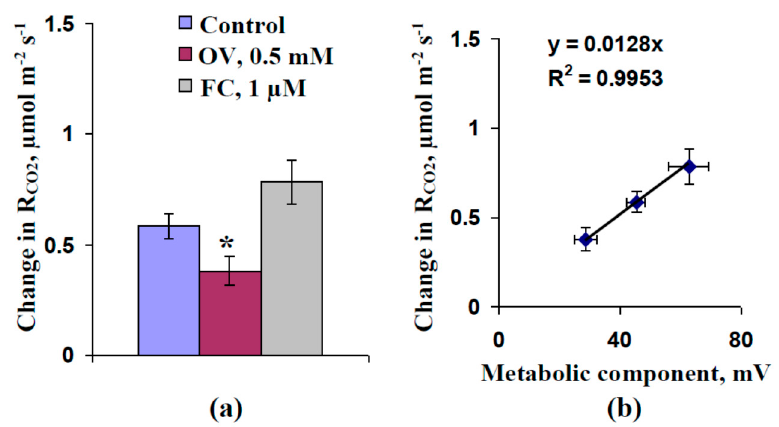
Figure 7. Magnitudes of local burning-induced changes in respiration (R CO2 ) ( a ) and scatter plot between the values of the metabolic component of the membrane potential and the magnitudes of these changes ( b ) ( n = 5–6). Respiration was measured under dark conditions. The preliminary OV (0.5 mM) and FC (1 µM) treatments of the second mature leaves in seedlings were performed by incubation of the leaf (2 h) in solutions of these chemical agents. After that, these leaves were dried using filter paper and used for respiratory measurement. OV and FC were dissolved in standard solution (1 mM KCl, 0.5 mM CaCl 2 , and 0.1 mM NaCl). Similar incubation in the standard solution was used as a control. The first mature leaf was burned (flame, 2–3 s). The values of the metabolic component were taken from Figure 1. *, significant difference between experiment and control plants ( p < 0.05).